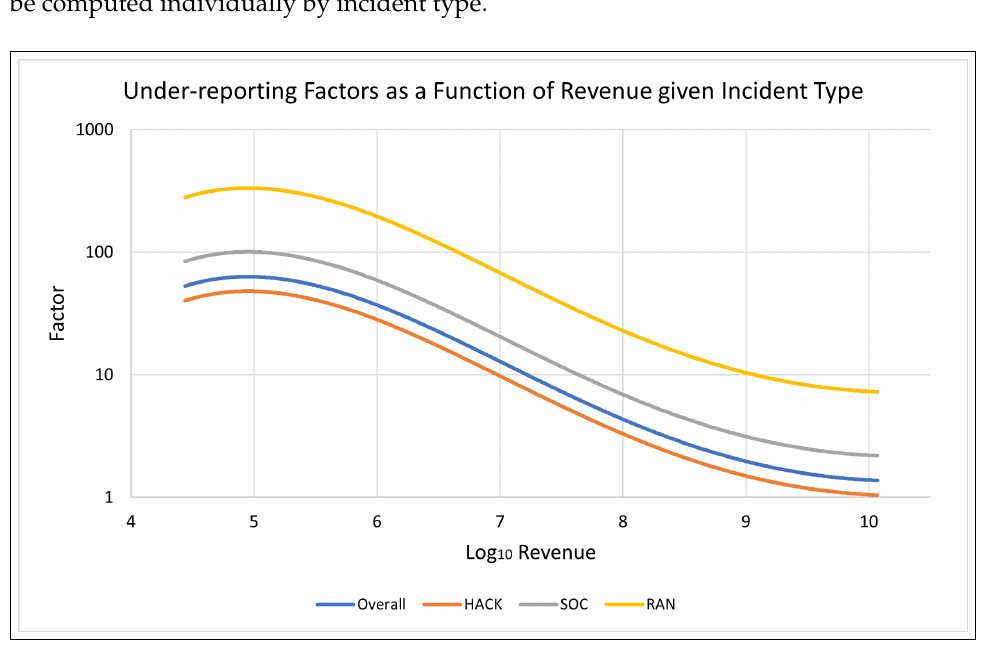
Figure 3. Under-reporting Factors as function of Revenue and Incident